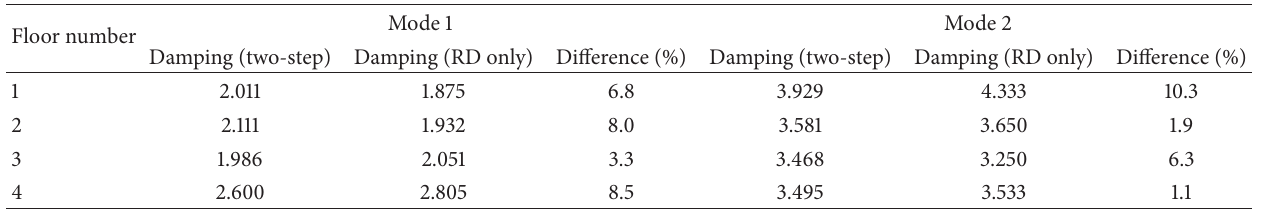
Figure 17: (a) Integrated displacement time histories at each floor in N-S direction and (b) their fast Fourier transformation (FFT) plots. Table 2: Comparison of the damping ratios estimated using the two